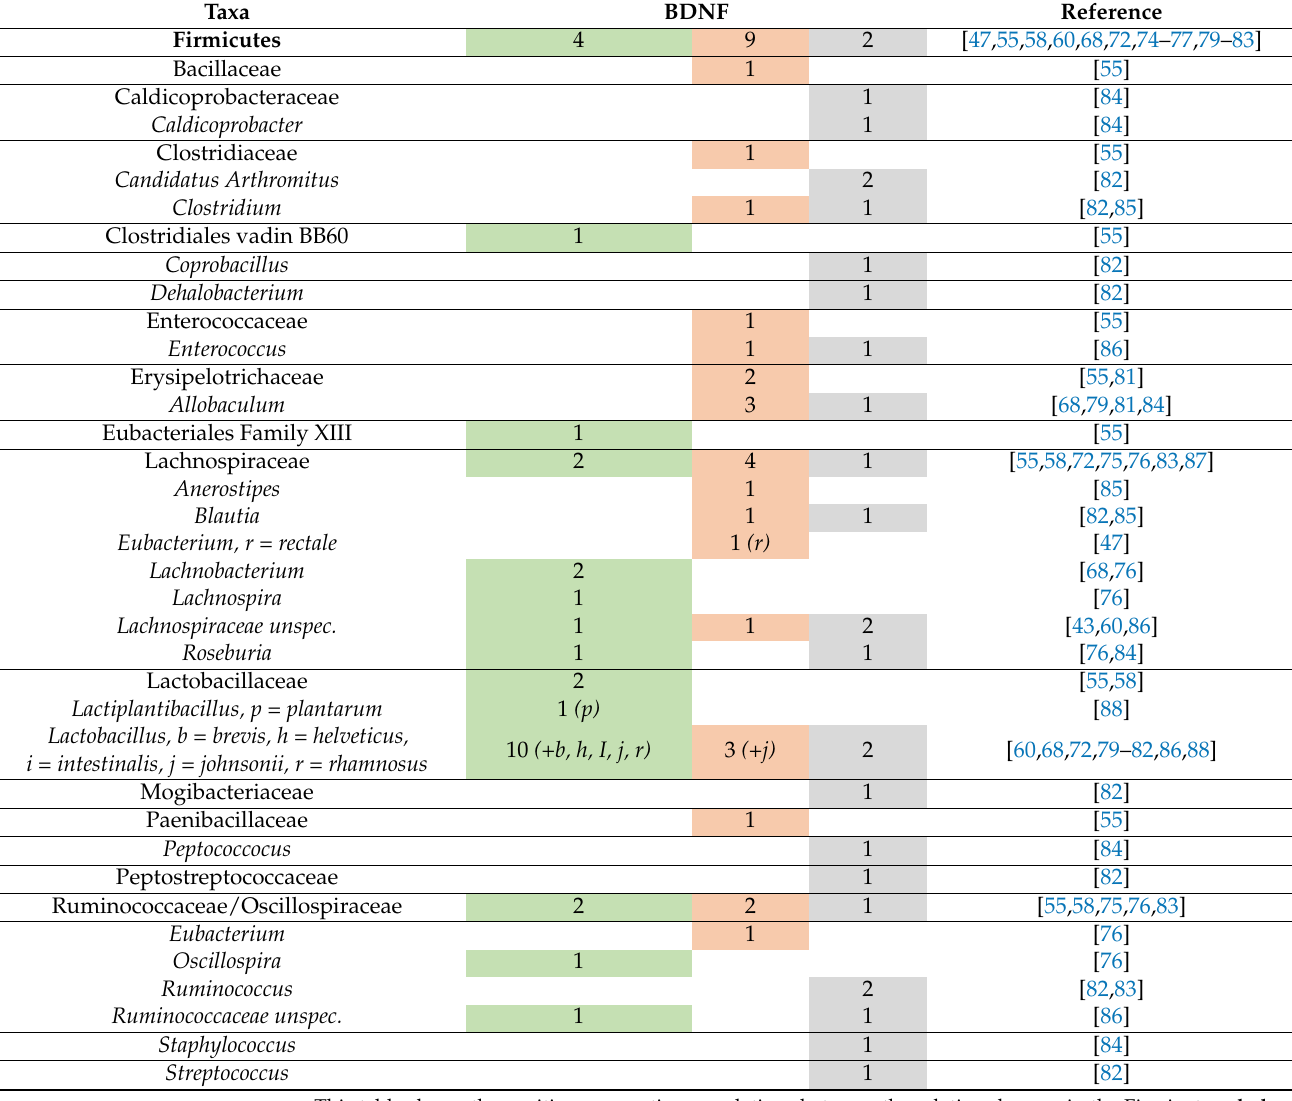
Table 4. Firmicutes and